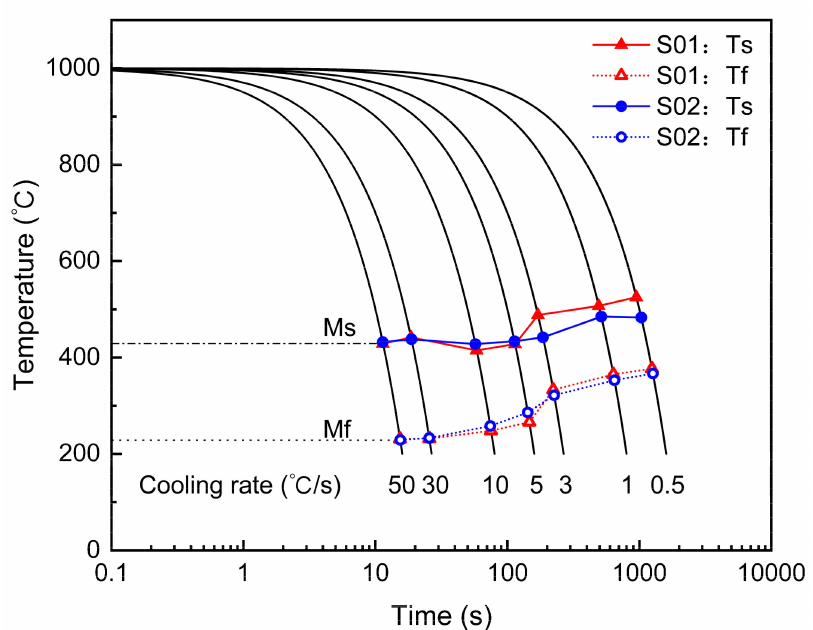
Figure 1. CCT diagrams of two steels at different cooling rates (S01: 0.16C-0.92Ni steel, S02: 0.12C- 1.86Ni, Ts/Ms: starting temperature of phase transformation, Tf/Mf: finishing temperature of phase transformation).